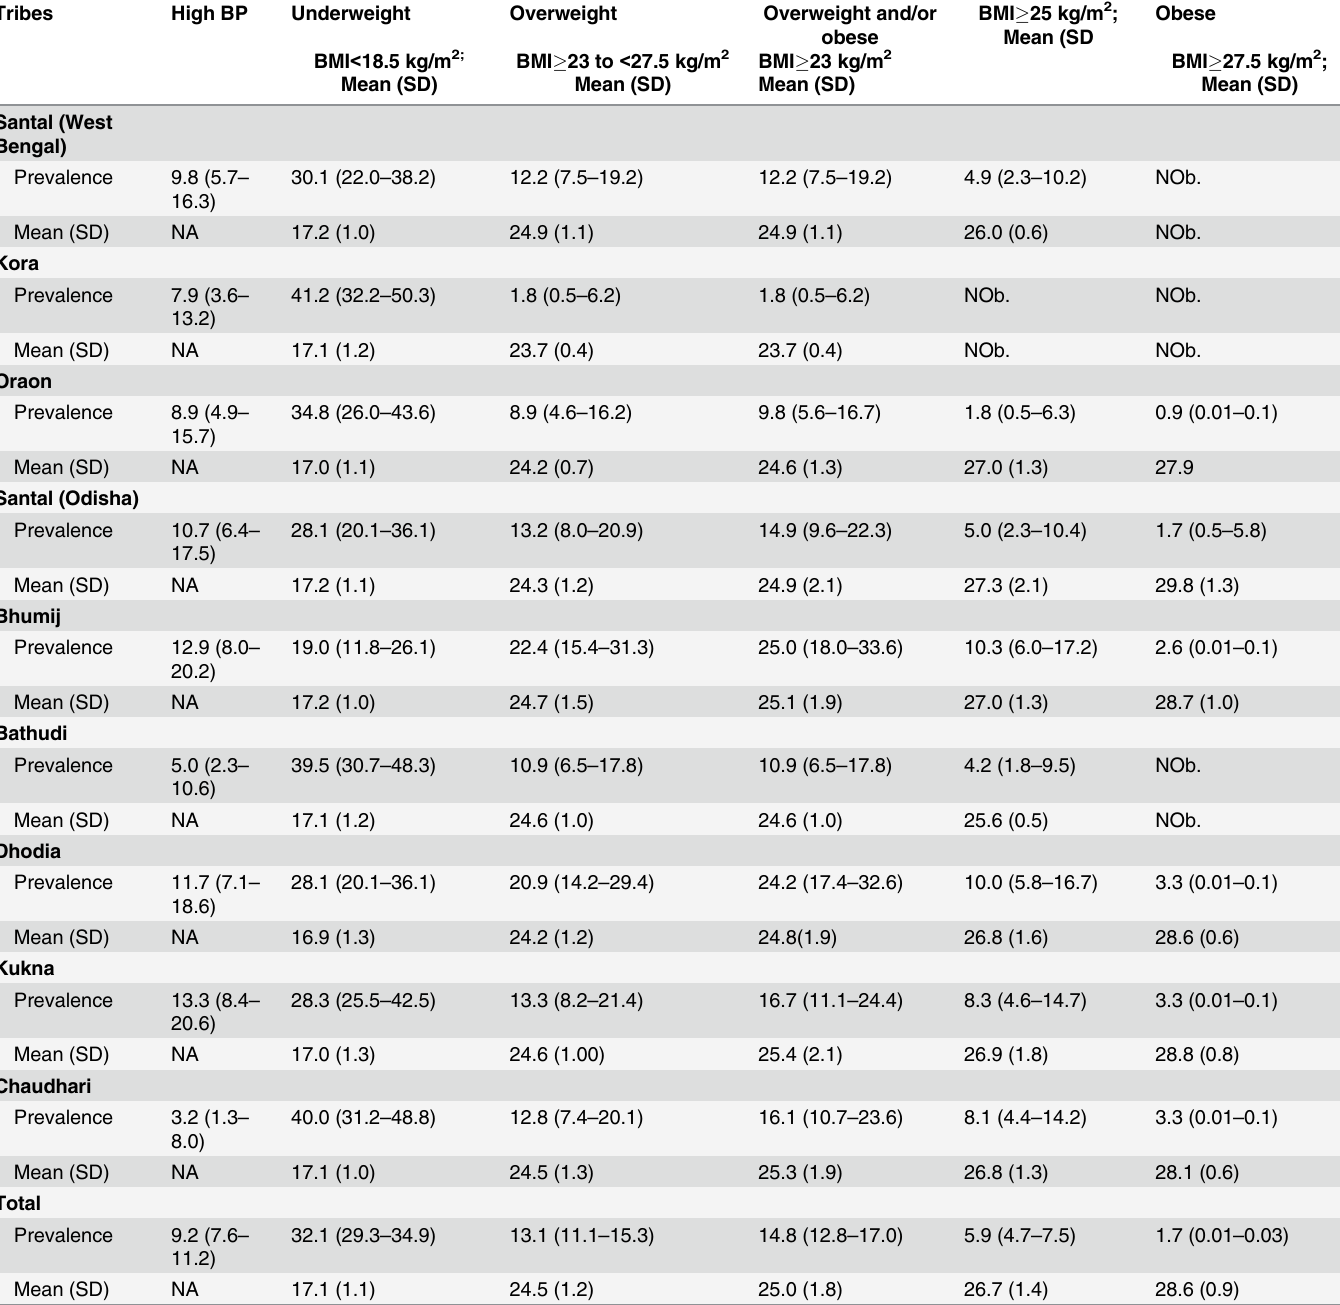
Table 3. Prevalence (%) of high blood pressure, underweight (BMI < 18.5 kg/m 2 ), overweight and/or obese (BMI (cid:1) 23 kg/m 2 ), and obese (BMI (cid:1) 27.5 kg/m 2 ) among the men (95% CI) with mean and standard deviation. Tribes High BP